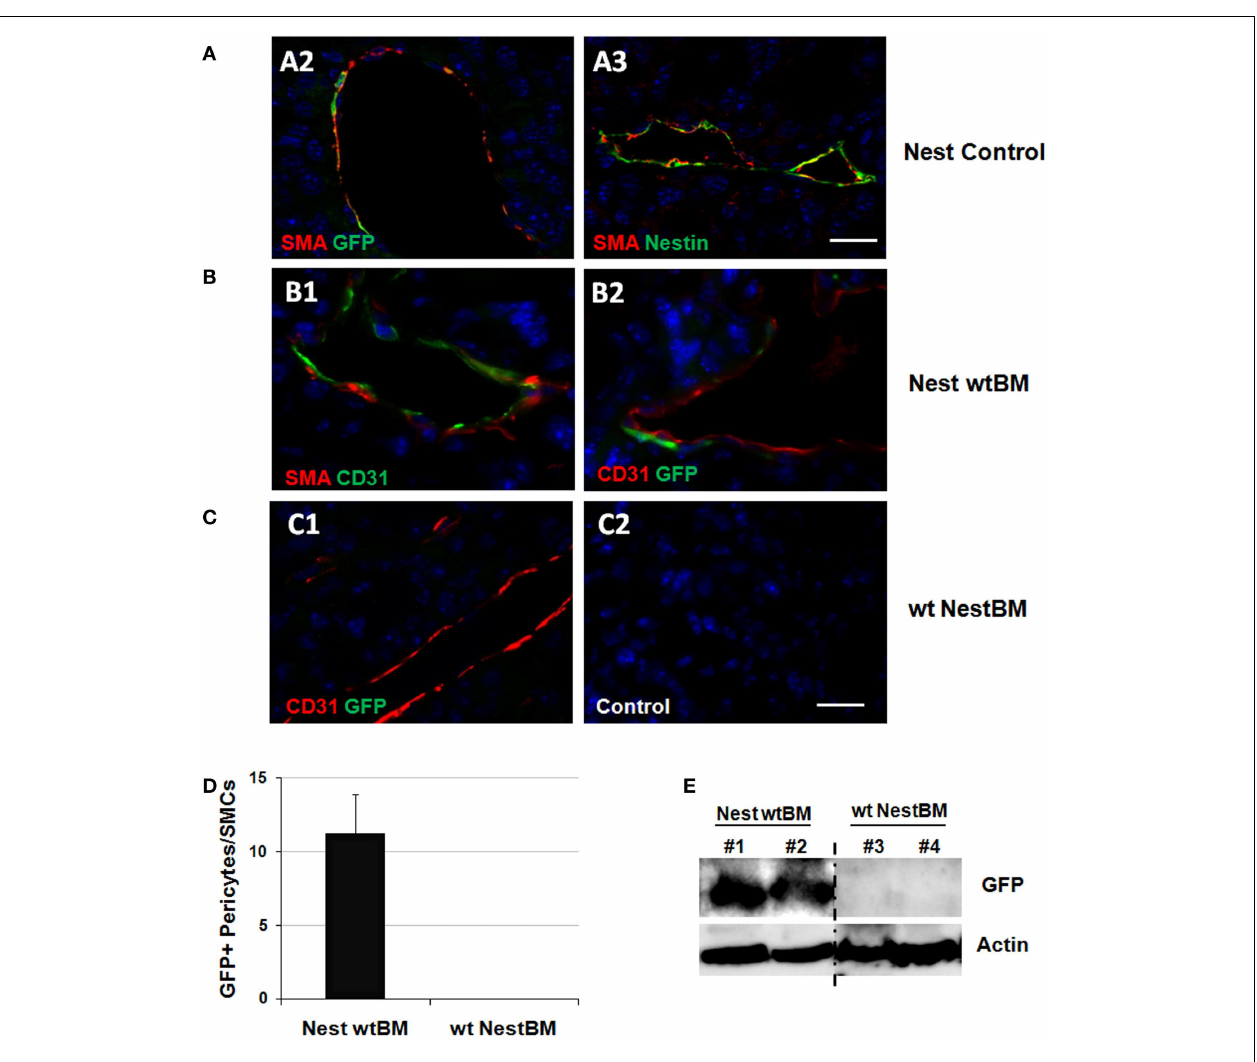
subcutaneously in the flank of BM-reconstituted Nest-GFP mice. NestwtBM, Nest-GFP mice received bone-marrow (BM) from wt (C57Bl/6) mice after lethally total body irradiation (7 + 3Gy). (C) Experiment with reciprocal BM chimera as shown in (B) . wtNestBM, wt mice received bone-marrow (BM) from Nest-GFP mice after lethally total body irradiation. Scale bar 20 µ m. (D) GFP-expression was quantified by counting GFP- and SMA-immunoreactive vascular structures (pericytes/SMC-stabilized vessels). (E) GFP-expression was further analyzed usingWestern blot